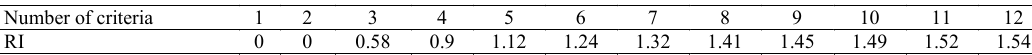
Table 3: Random inconsistency indices